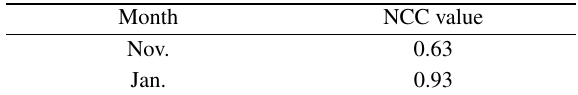
Table 18 NCC value between combined English and Arabic tweets (classified as self and nonself) and count of actual hospital